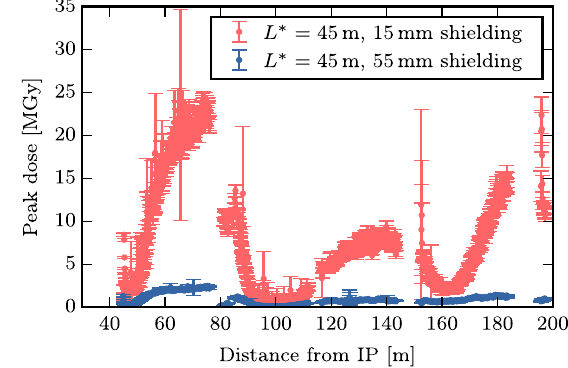
FIG. 14. Peak dose distributions L (cid:2) ¼ 45 m for vertical cross- ing with a shielding thickness of 55 mm for an integrated luminosity of 3000 fb − 1 . The massive increase in shielding reduced the dose by a factor of